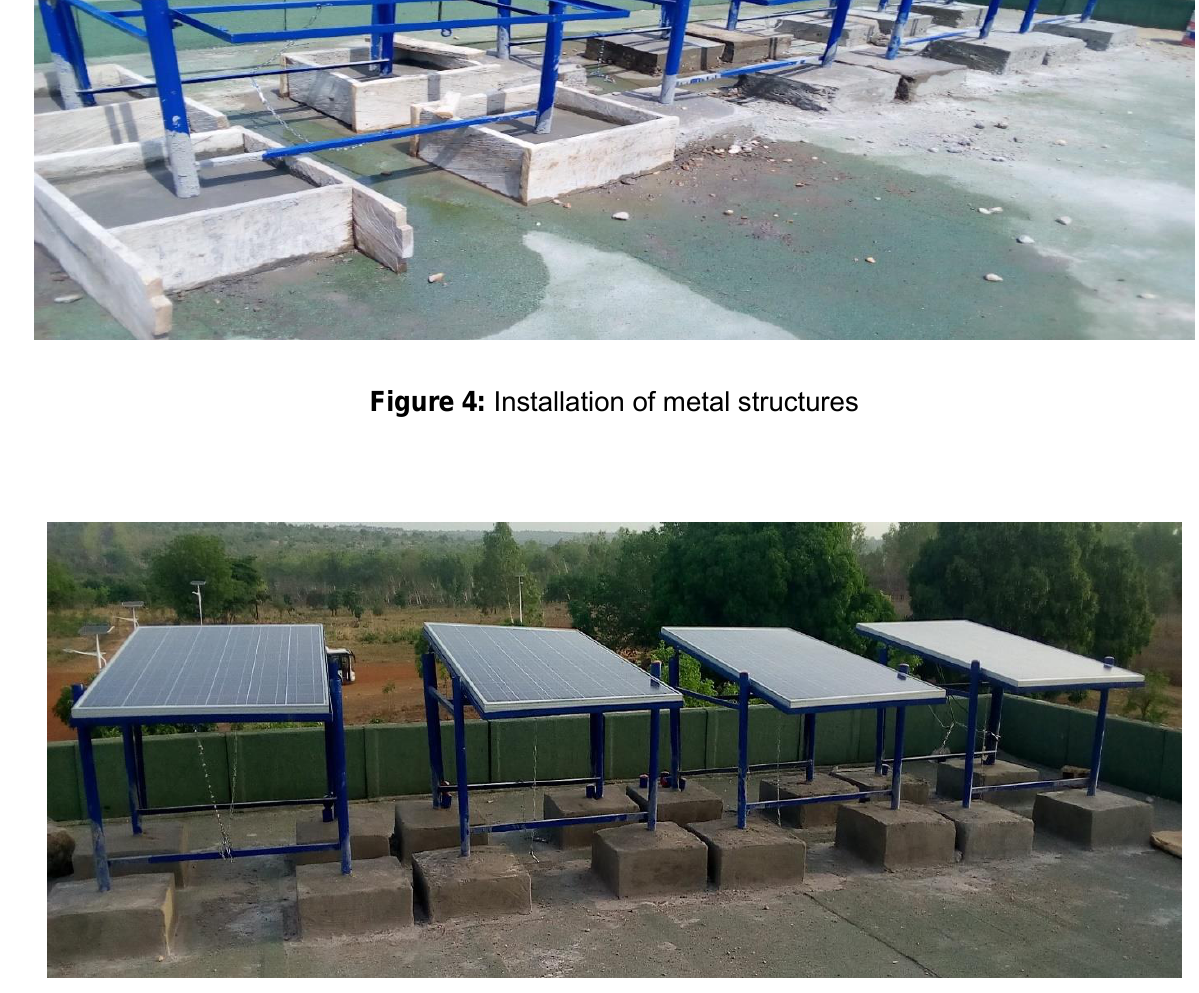
Figure 5: Photovoltaic field installed on the roof of the